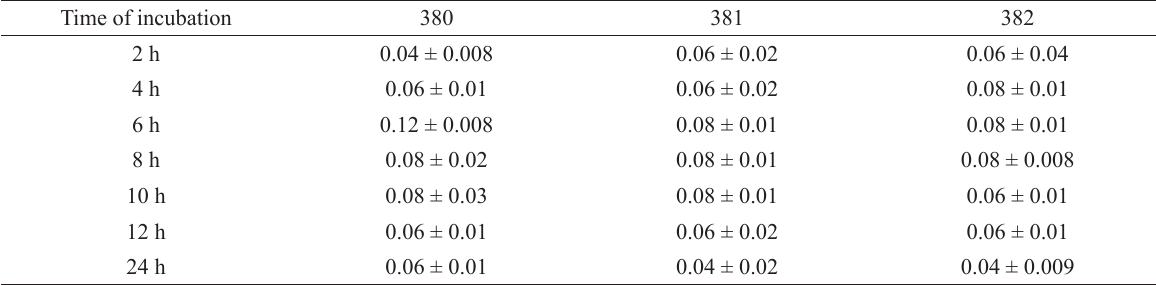
CMCase enzyme activity (UEA mL -1 min -1 ) for isolates selected and cultured at 50°C in submerged culture supplemented with 0.5% of CMC.